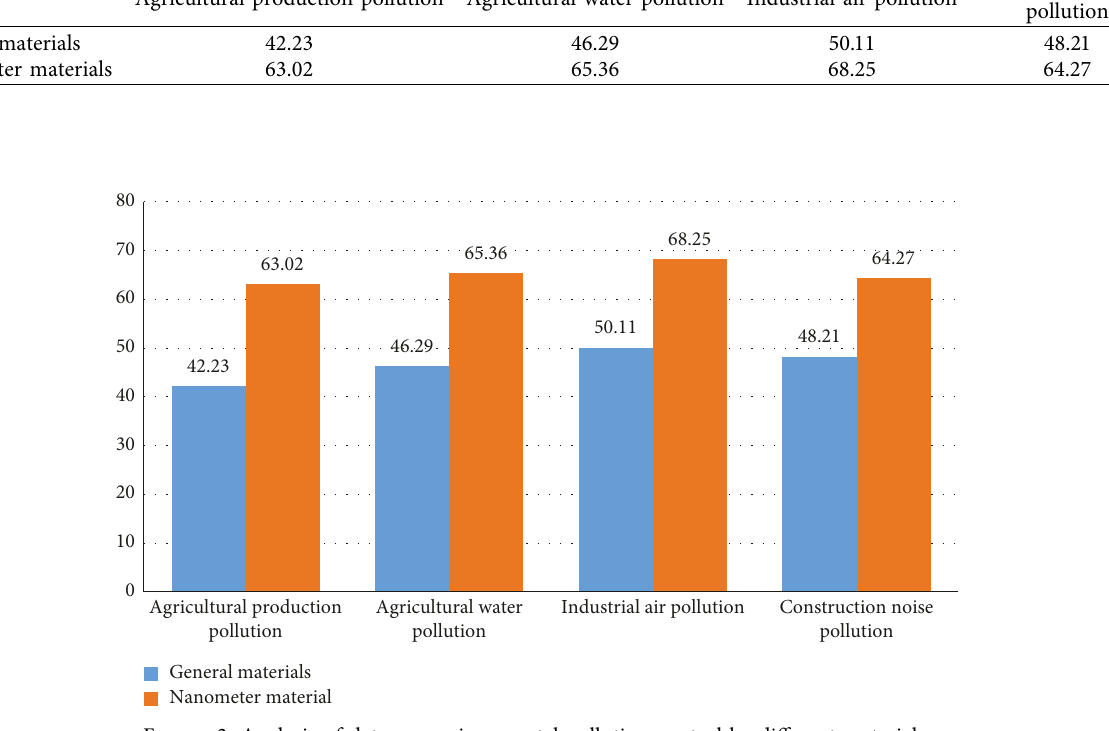
Table 1: Comparative analysis of environmental pollution control effects under different materials. Group